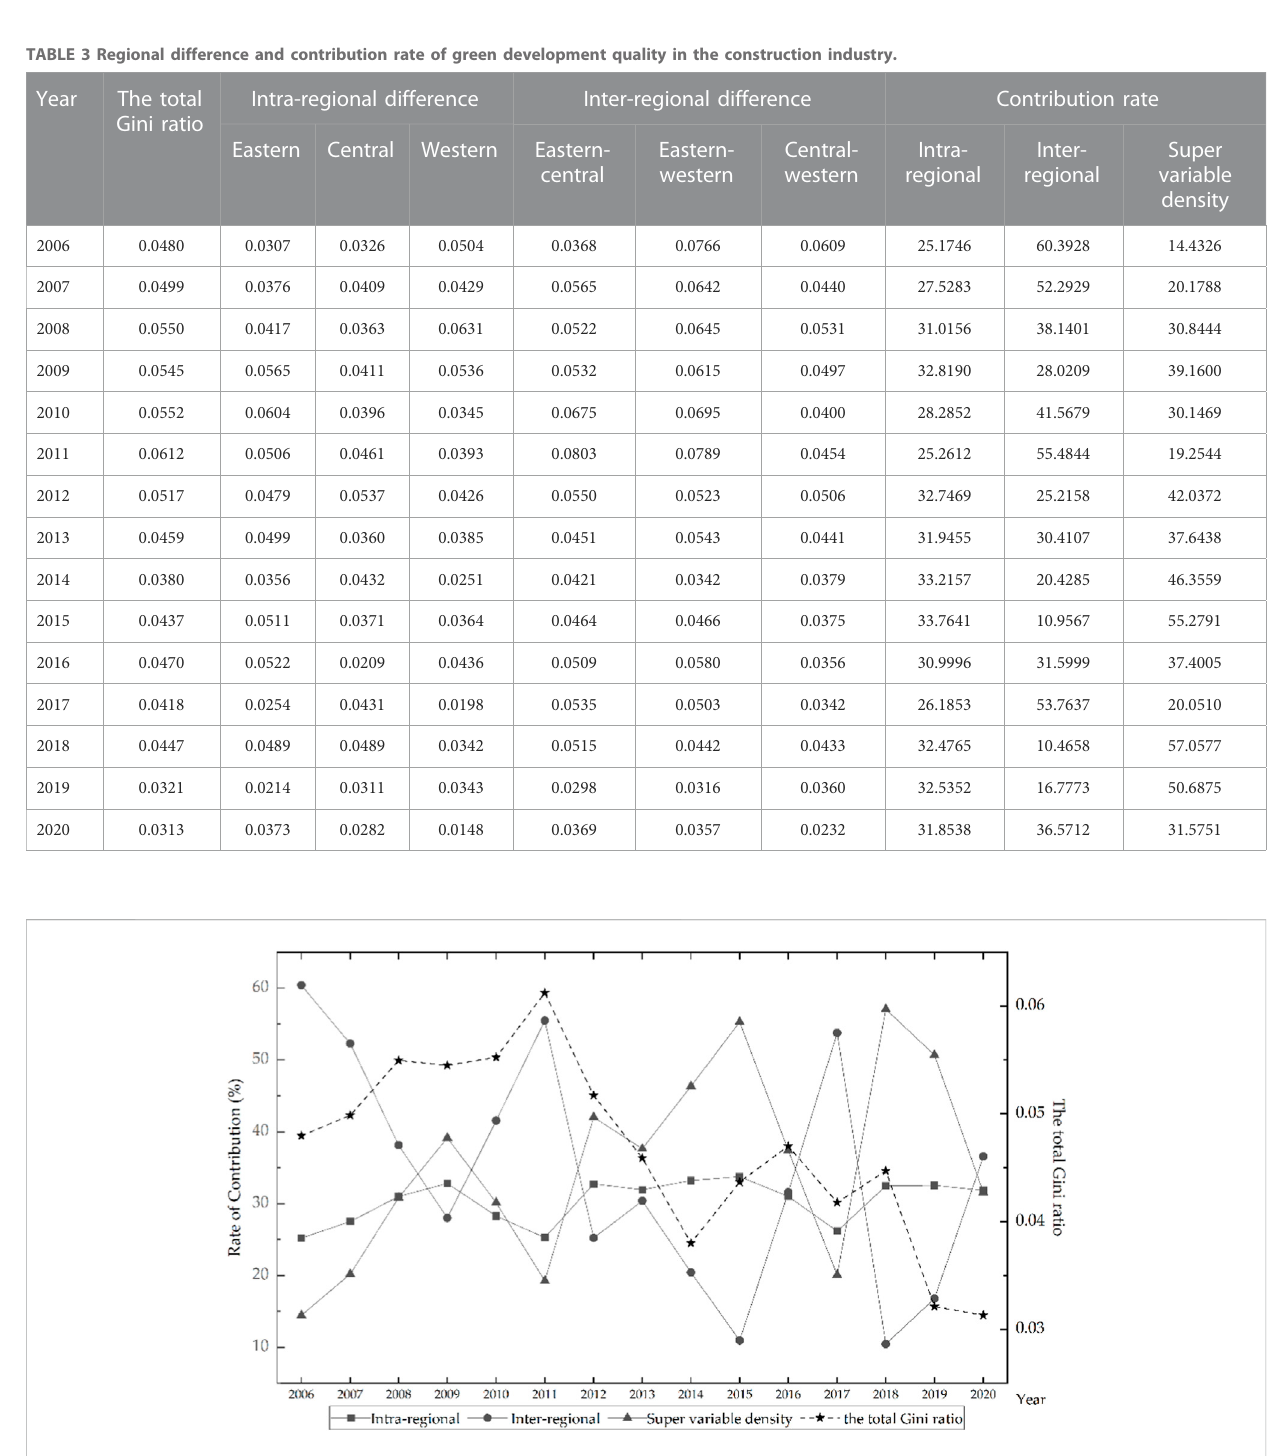
regional Gini coef fi cient declined by 0.0409, approximately 53.4%. The